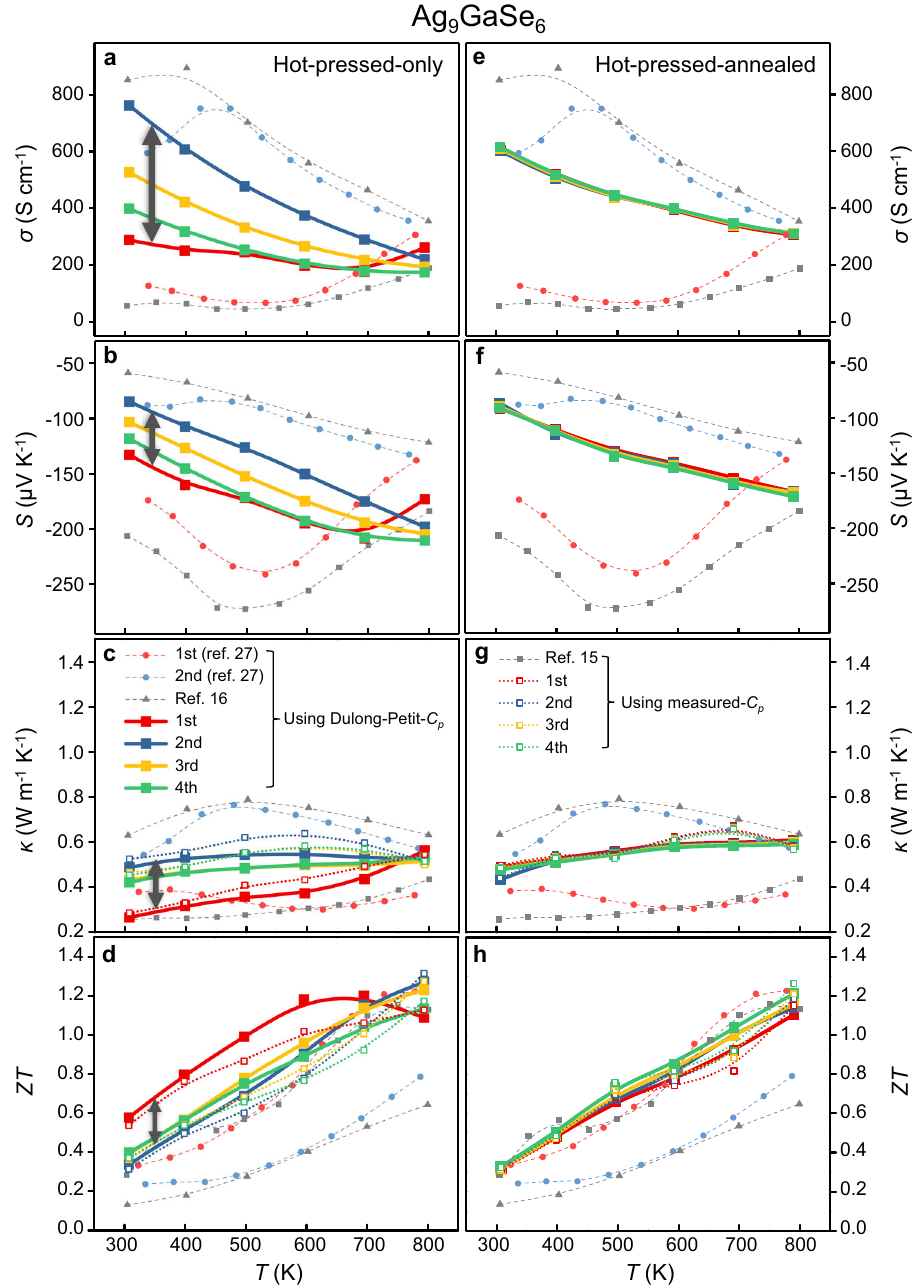
Fig. 2 Temperature-dependent thermoelectric properties of Ag 9 GaSe 6 . a – d hot-pressed-only, and e – h hot-pressed-annealed samples. a , e Electrical conductivity σ . b , f Seebeck coef fi cient S . c , g Thermal conductivity κ . d , h Figure of merit ZT . The κ and ZT calculated by both the measured- C p and Dulong- Petit- C p and those reported 15,16,27 are presented. The gray double arrows indicate the signi fi cant discrepancy observed on the hot-pressed-only samples. The measured- C p are provided in Supplementary Information Supplementary Fig.